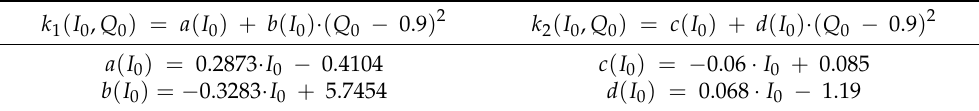
Table A1. Equations resulting from numerical